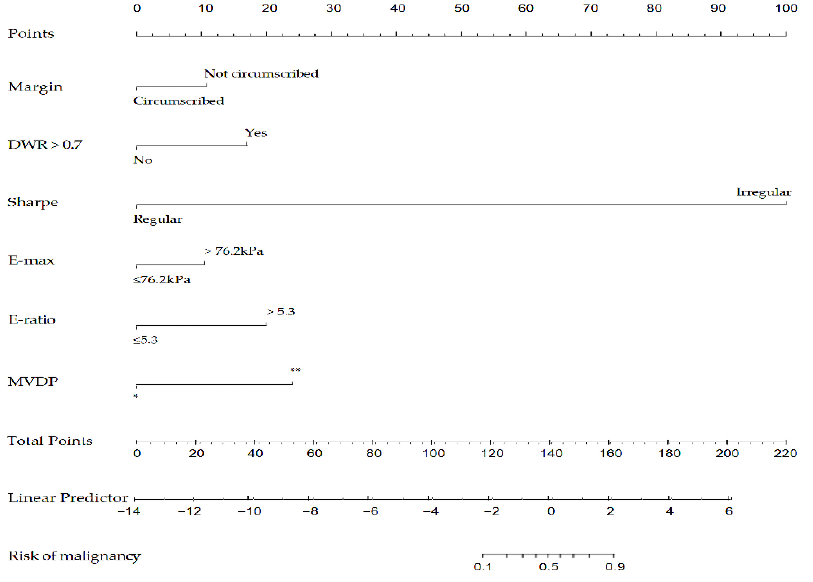
Figure 6. A nomogram to predict the risk of breast cancer for patients with breast lesions. DWR: depth-width ratio; E-max: Elasticity maximum; E-ratio: Ratio of Elasticity of lesion to normal tissue; MVDP: microvascular distribution pattern; *, non-vascular pattern, linear or curvilinear pattern and tree-like pattern; **, root hair-like pattern and crab claw-like pattern.